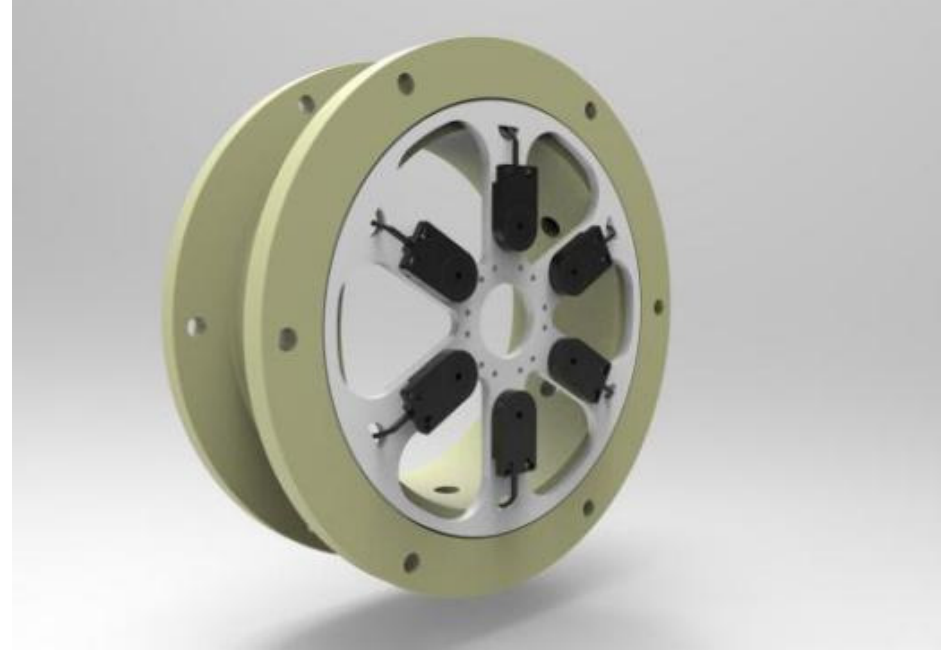
Figure 3. The specific structure of the sensor array with six SnO 2 gas sensors.